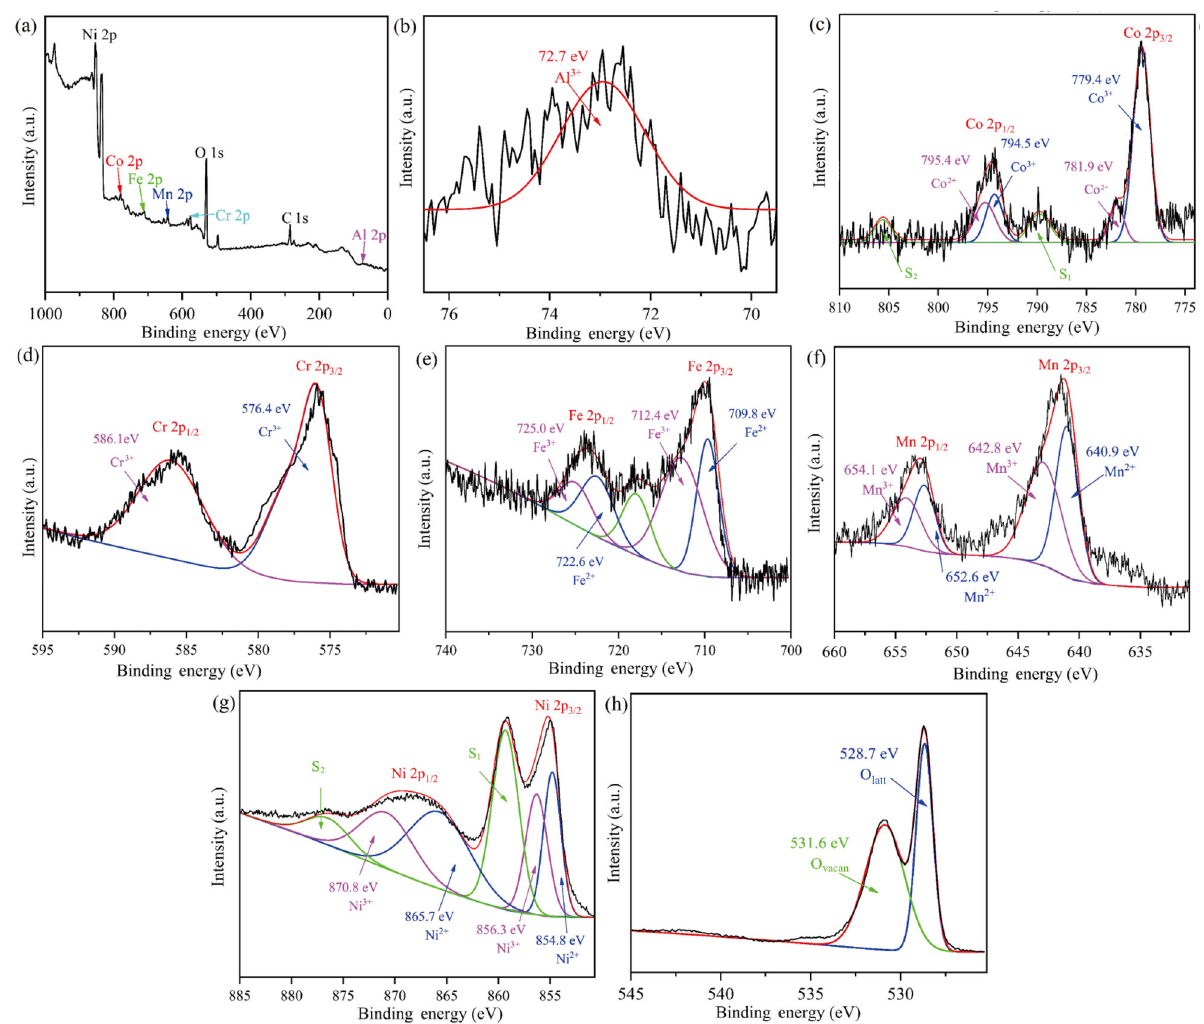
Fig. 9 XPS spectra of La(CoCrFeMnNiAl 0.5 ) 1/5.5 O 3 − δ